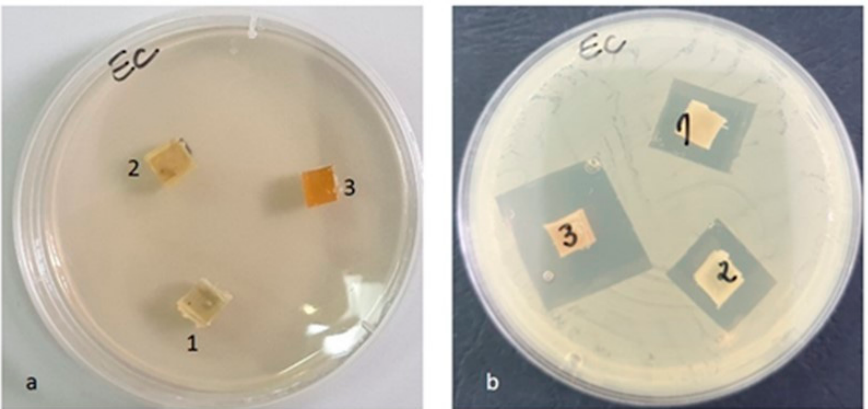
Figure 15. Escherichia coli ATCC 25922 ( a ) zero (initial) moment, ( b ) inhibition after 48 h of incubation.